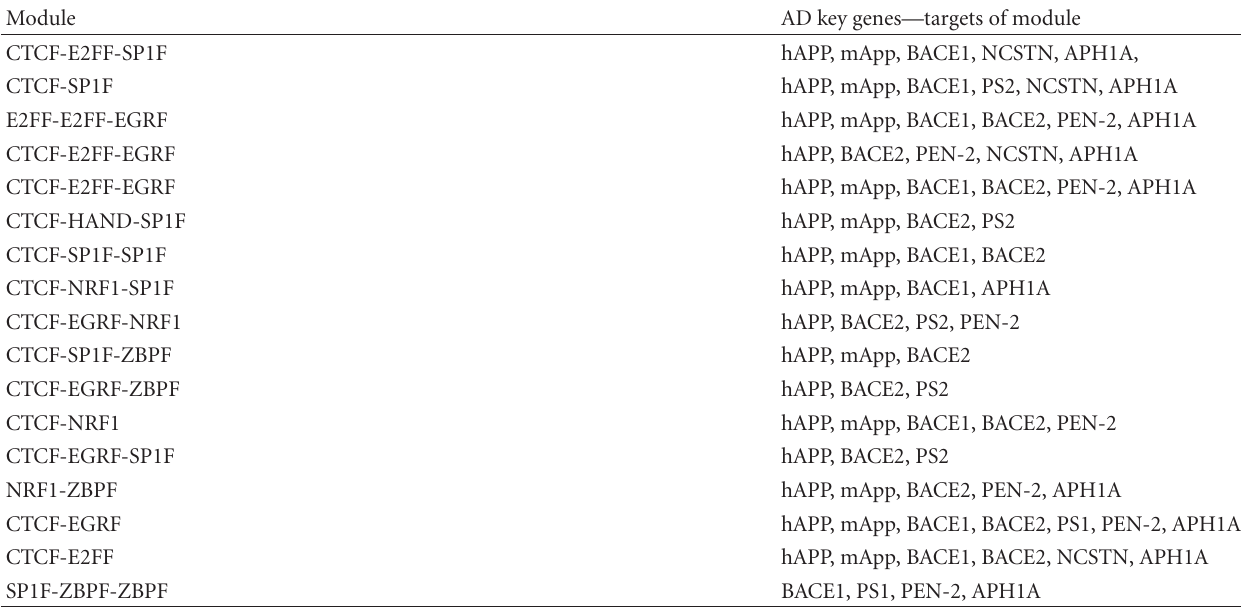
Table 1: Modules identified by the first approach: 17 modules composed of two or more TFBSs families. The TFBSs families consist of several TFs (Table 2). The second column specifies the key genes of AD the TFs of the module bind to, according to the search of the module in all human promoters by ModelInspector. Human and mouse APPs are indicated by hAPP and mApp, respectively. Module AD key genes—targets of module